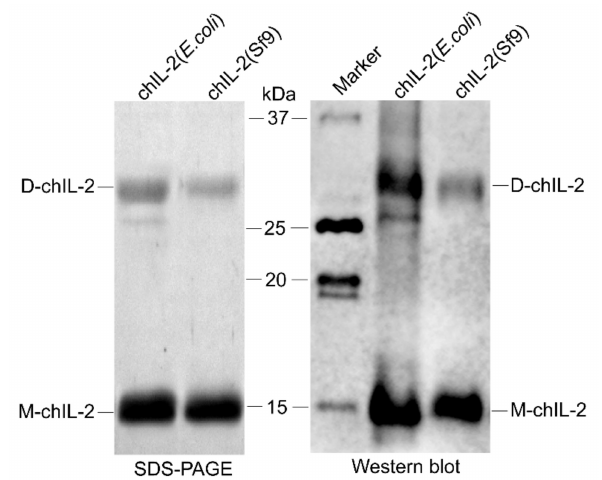
Figure 1. Identification of purified chIL-2. Purified chIL-2 proteins were identified by SDS-PAGE and Western blotting. D-chIL-2, chIL-2 dimer; M-chIL-2, chIL-2 monomer; chIL-2 ( E. coli ), chIL-2 protein purified from E. coli cells; chIL-2 (Sf9), chIL-2 protein purified from Sf9 cells; Marker, protein standard marker.